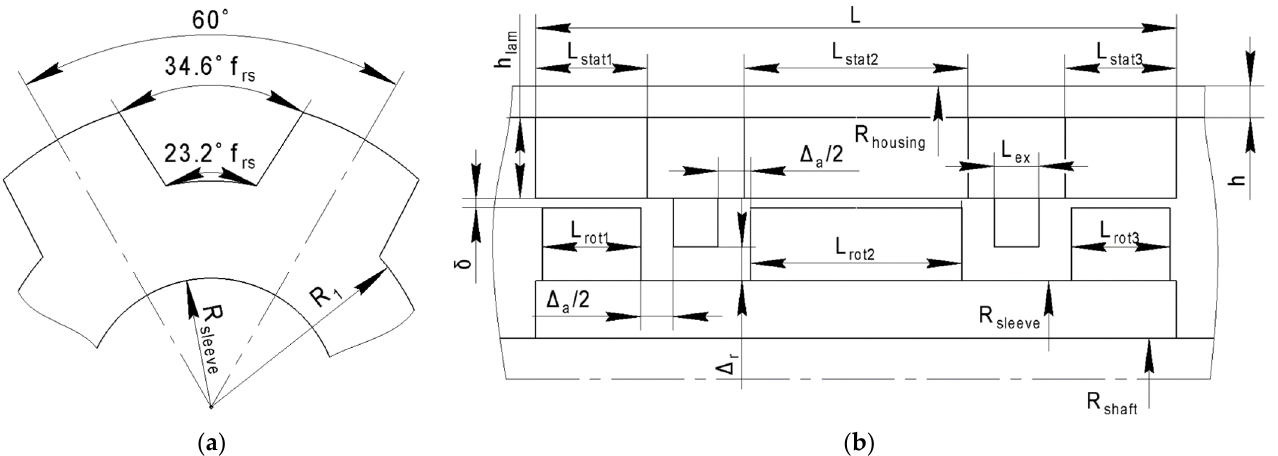
Figure 4. SHM geometric parameters. ( a ) Rotor parameters; ( b ) stator and rotor parameters. Table 2. Some geometric parameters fixed during the optimization.